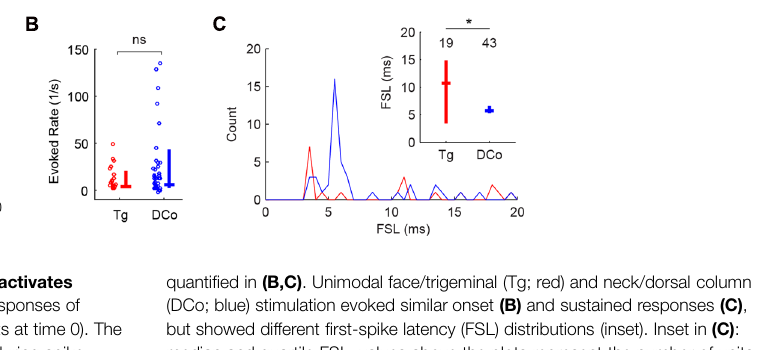
quantified in (B,C) . Unimodal face/trigeminal (Tg; red) and neck/dorsal column (DCo; blue) stimulation evoked similar onset (B) and sustained responses (C) , but showed different first-spike latency (FSL) distributions (inset). Inset in (C) : median and quartile FSL; values above the plots represent the number of units. ∗ P <